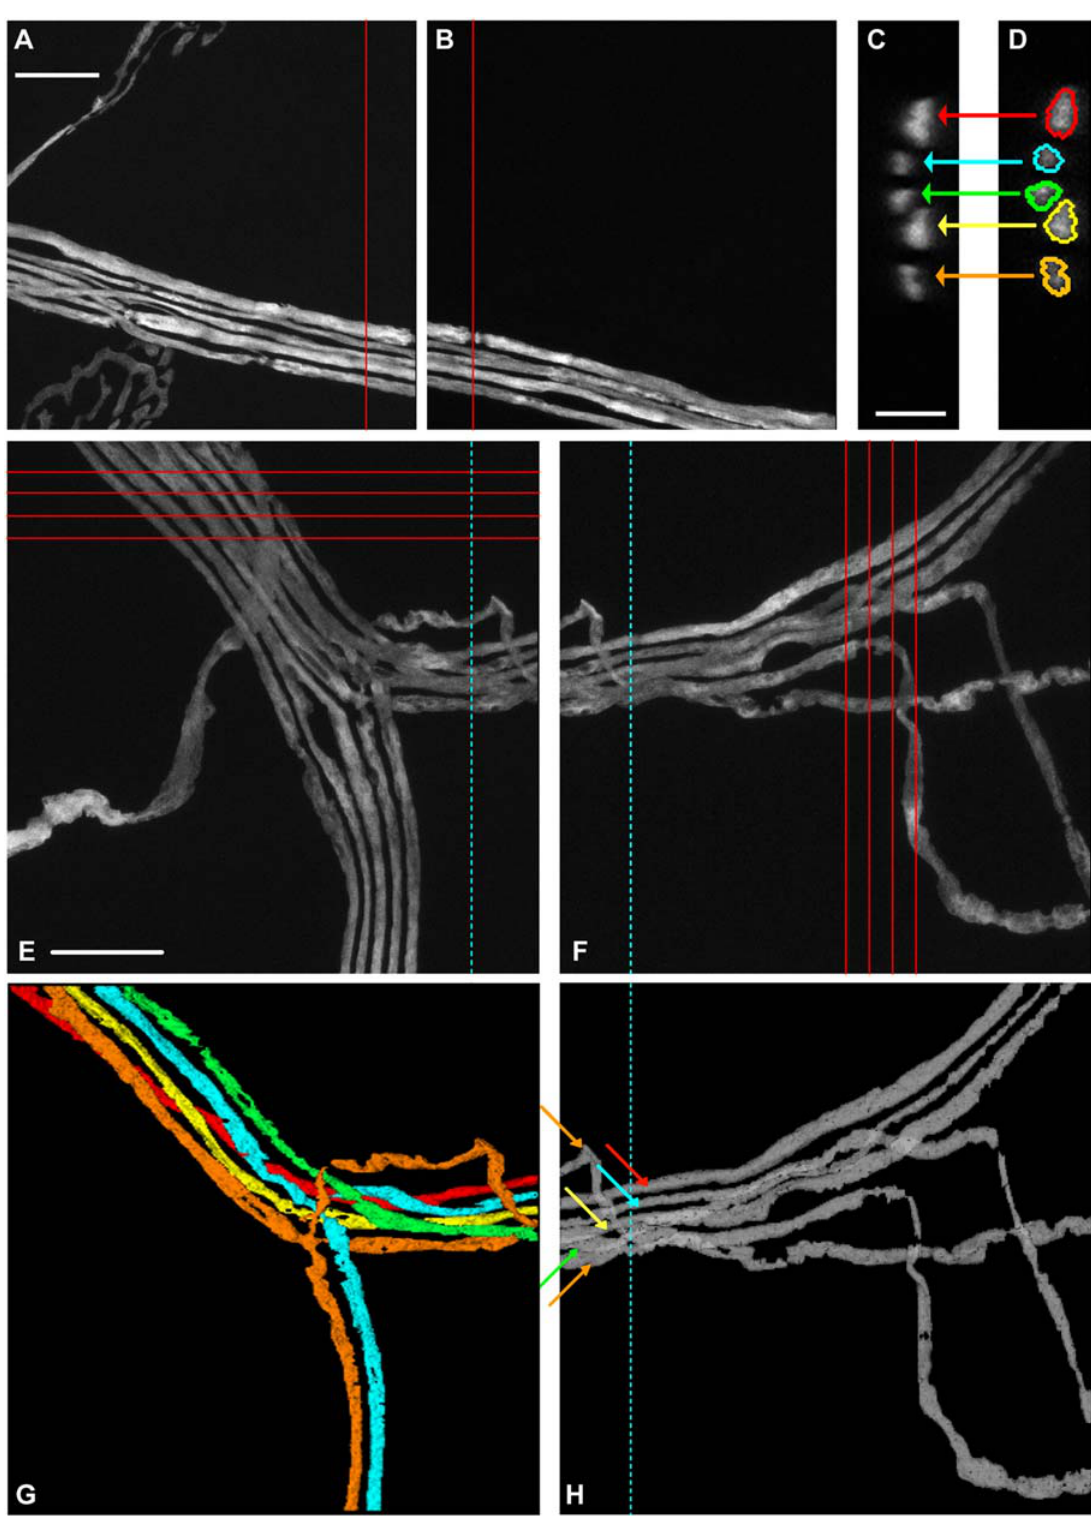
Figure 6. Concatenation of adjacent stacks. A–B . Two adjacent stacks with the same preferred axis. Red lines: orientation of virtual sections. Scale bar: 20 m m. C–D . Cross-sections of the same axon in the two stacks were almost identical on corresponding virtual sections. C : section 231